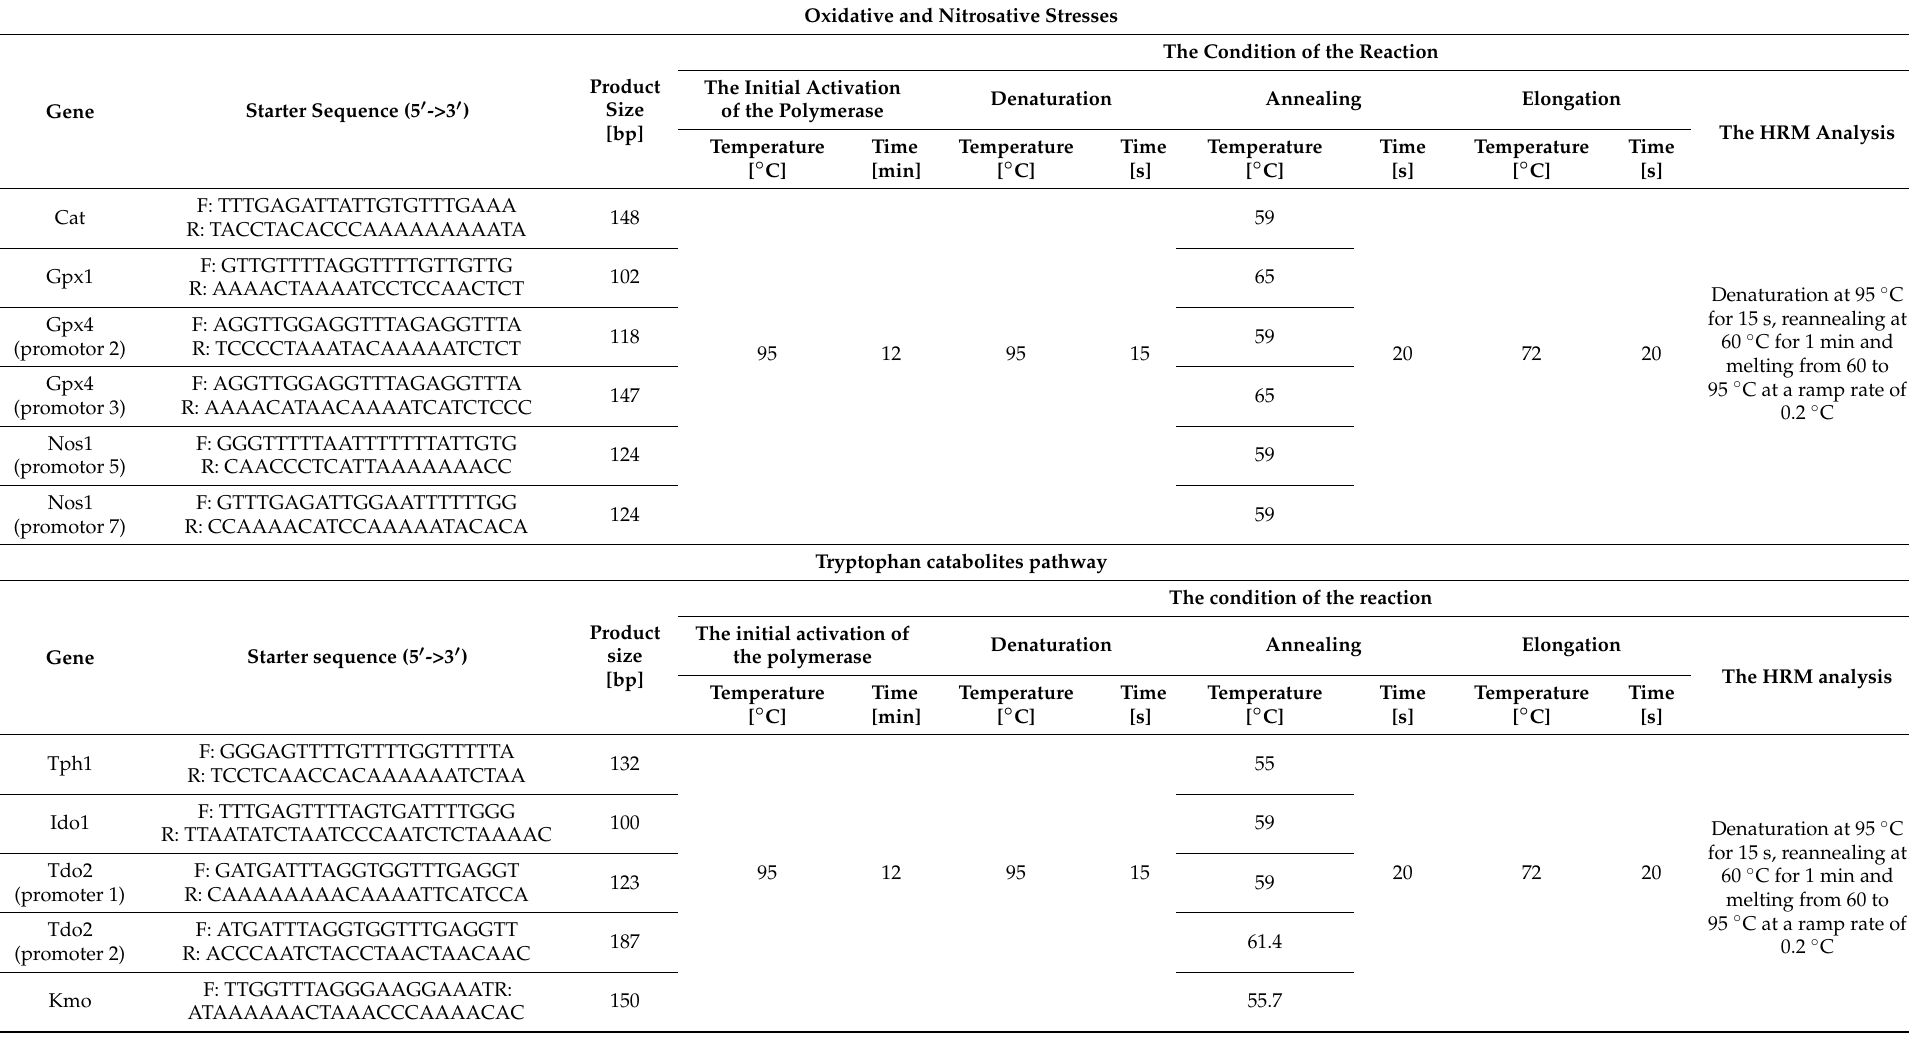
Table 2. Characteristic of primer and conditions of the MS-HRM